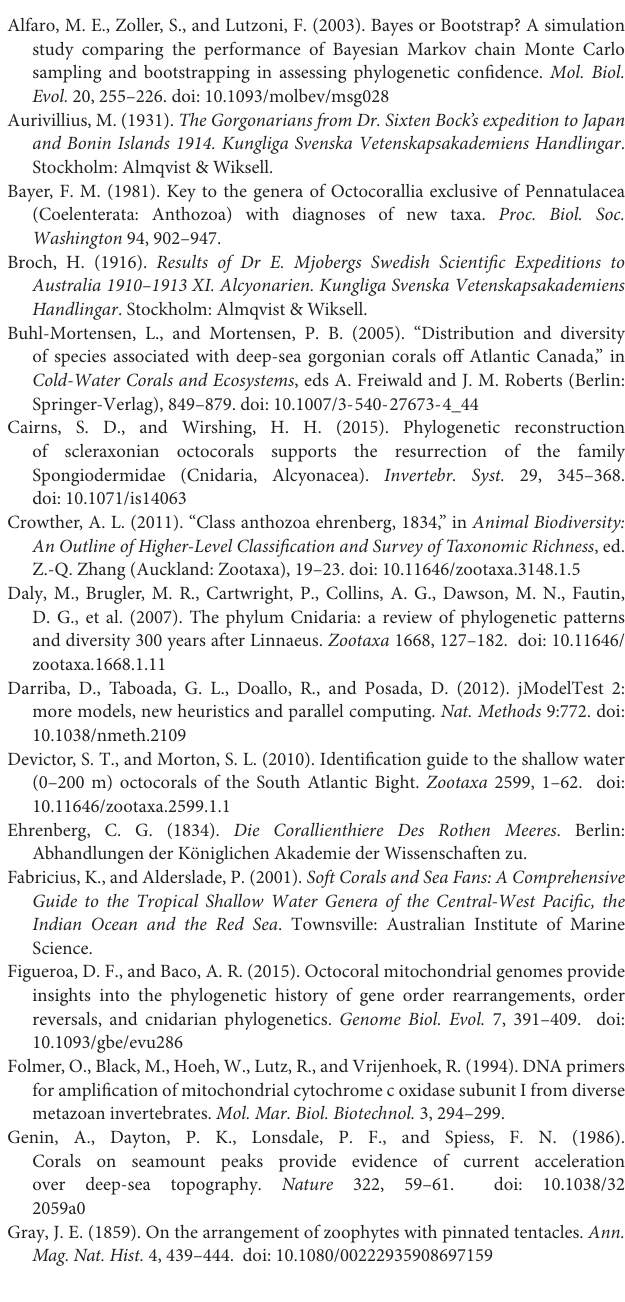
showing arrangement of sclerites. (B) Sclerites from tentacles. Scale bars = 0.2 mm (A) , and 100 µ m (B) . FIGURE S11 | Sclerites from the specimen MBM286394 of Victorgorgia eminens Moore et al., 2017. (A) Sclerites from points and collarets. (B) Sclerites from calyces. Scale bars = 100 µ m. FIGURE S12 | Sclerites from the specimen MBM286394 of Victorgorgia eminens Moore et al., 2017. (A) Sclerites from cortex. (B) Sclerites from medulla. Scale bars = 100 µ m.